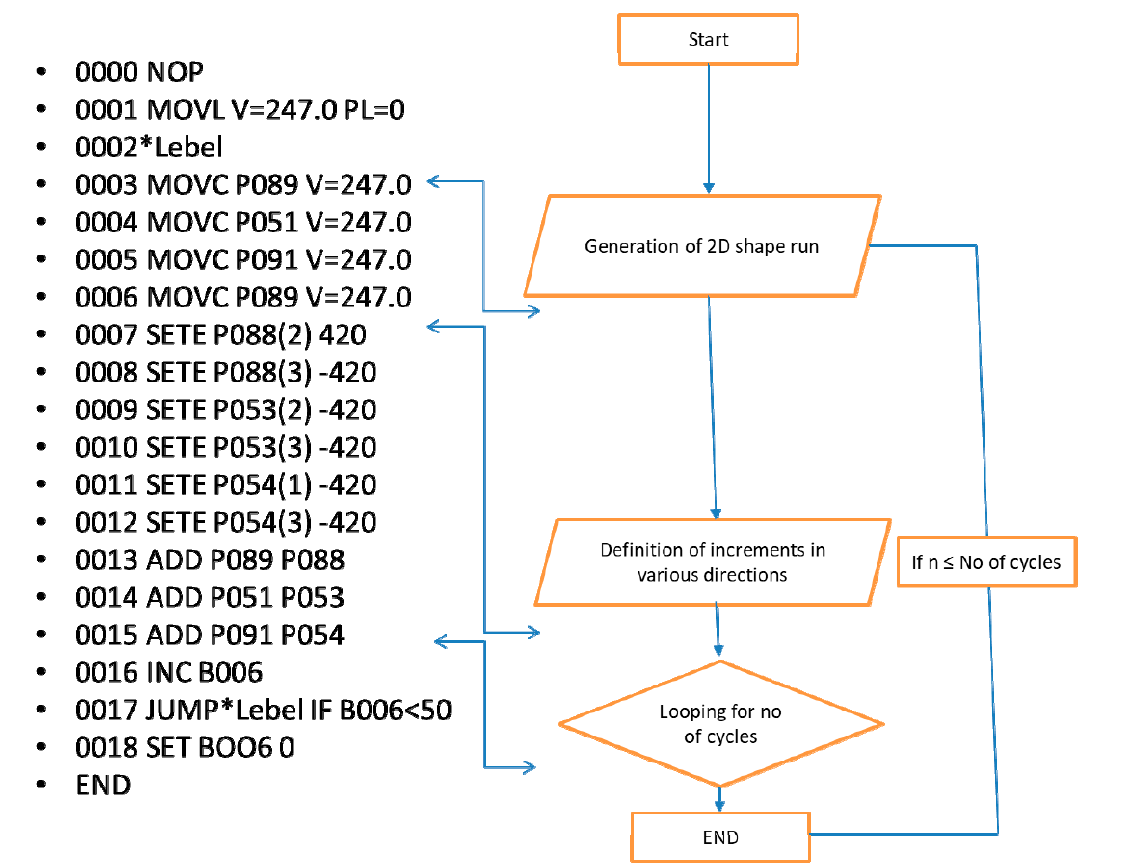
Figure 7. Tool path planning for generation of conical shape on 6-axis industrial robot.